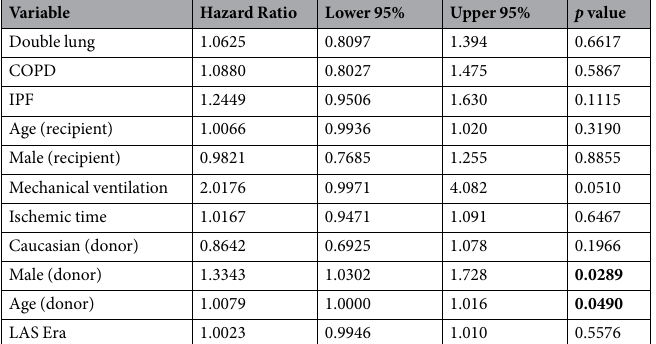
Table 2. Cox regression model in African Americans who undergone lung transplant for COPD, IPF and sarcoidosis in the US in from December 2005 through December